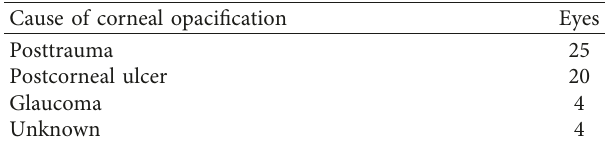
Table 1: Causes of corneal opacity in recruited patients for corneal